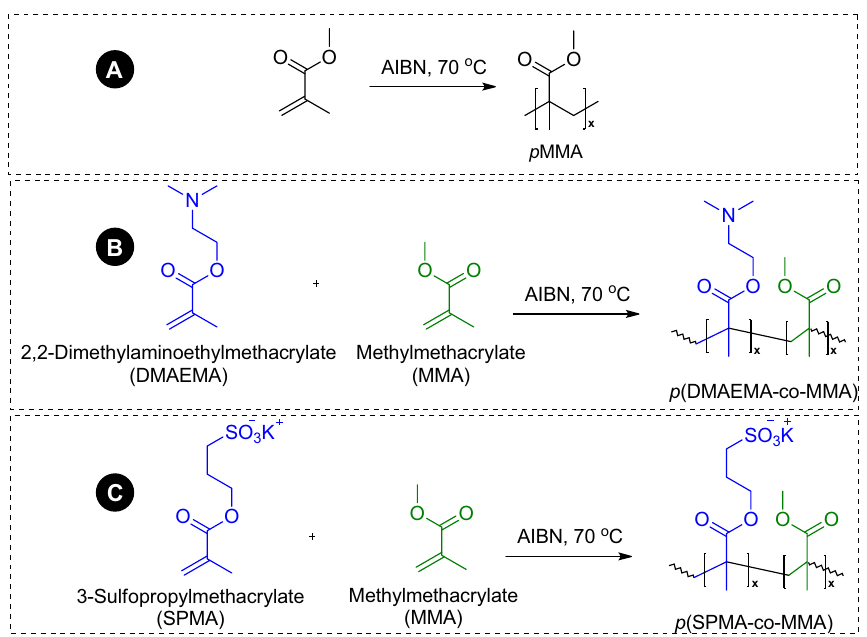
Figure 1. Synthesis of ( A ) pMMA; ( B ) p(DMAEMA-co-MMA) and ( C )